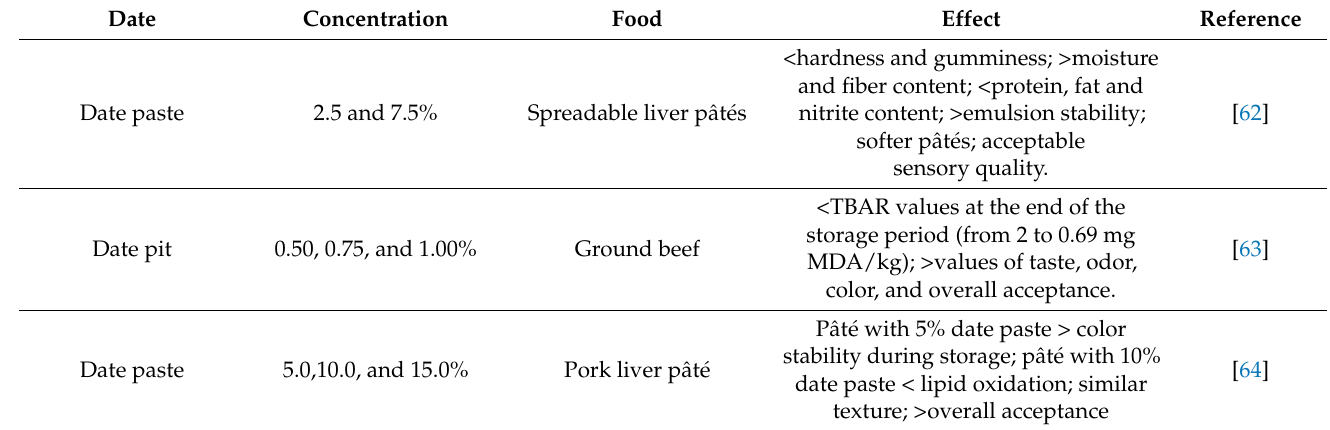
Table 1. Summary of different studies about the incorporation of date palm and its co-products in meat